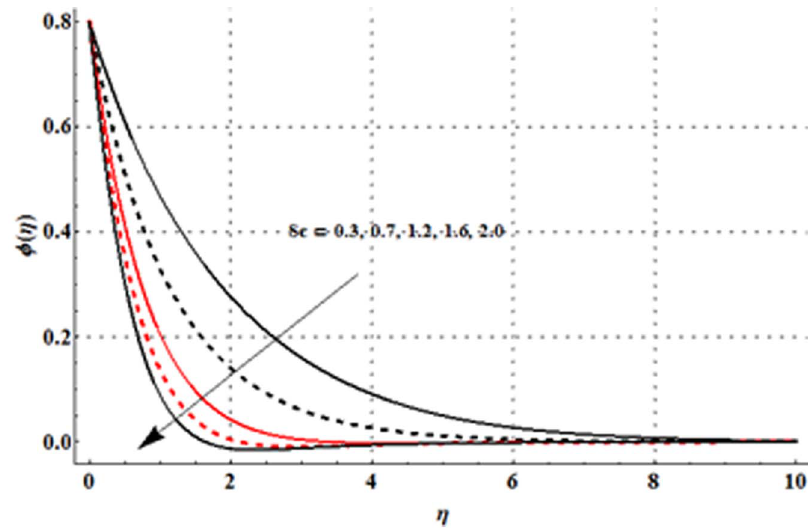
Figure 20. Influence of Sc on the concentration profile w ( g ) when M ~ 0 : 6, b ~ 0 : 4 ~ Rd , l 1 ~ 0 : 5, l ~ 0 : 3 ~ N , Pr ~ 1 : 2 and S ~ 0 : 2 ~ S (cid:2) :